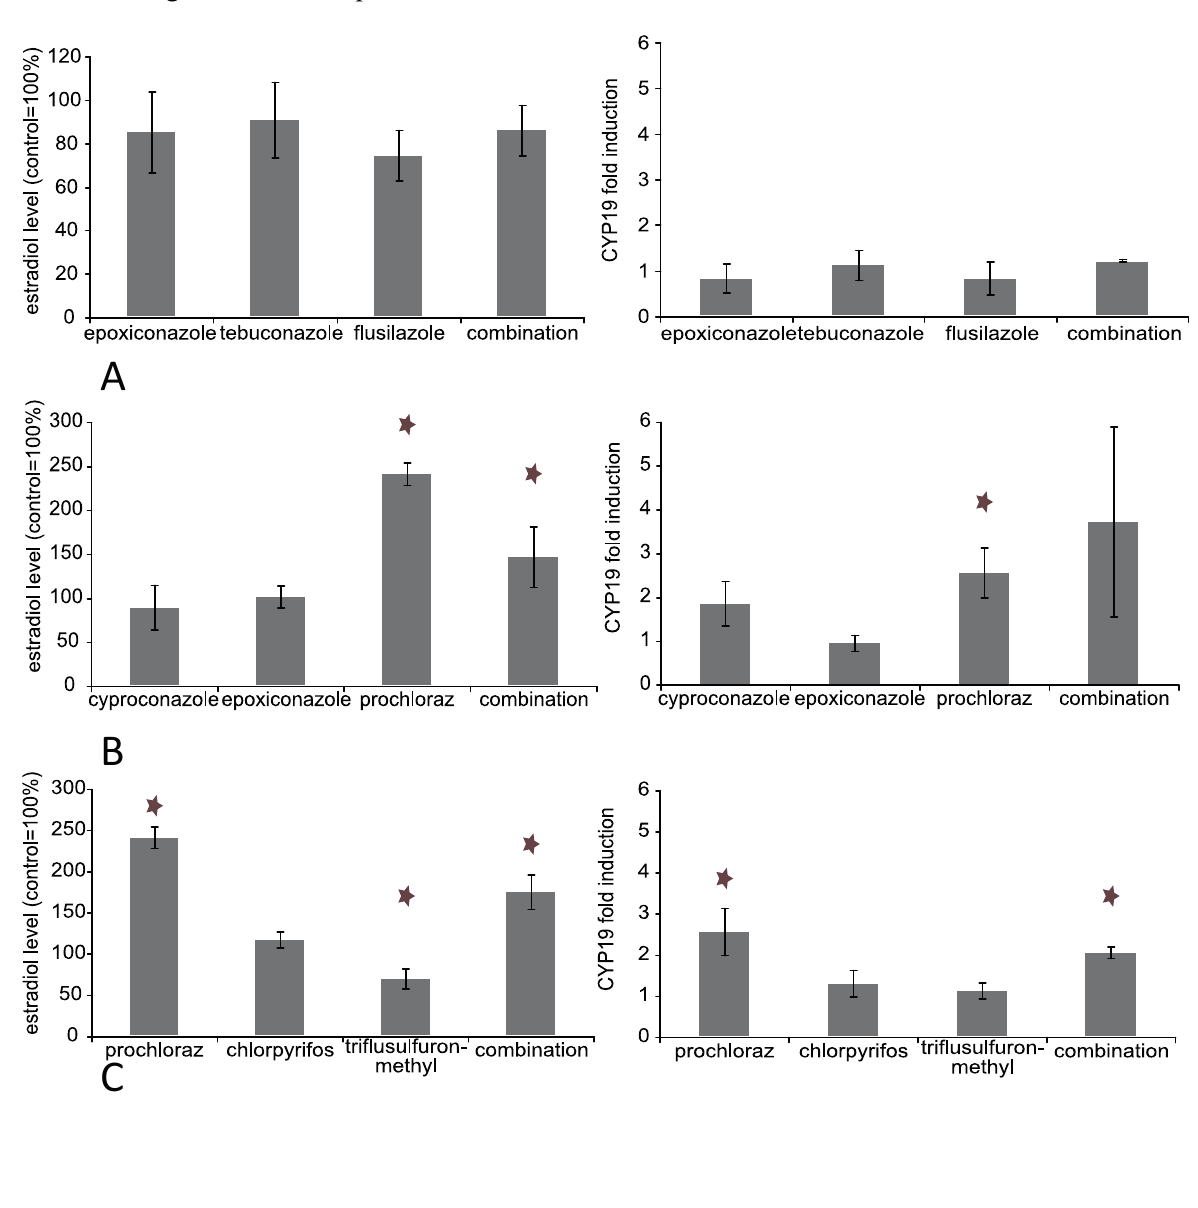
Figure 2. Influence of active substances alone or in combination on estradiol production and CYP19 mRNA expression in Jeg-3 cells. Jeg-3 cells were grown in 6-well cell culture plates for 24 h. Thereafter, the cells were incubated with the substances in total concentrations of 30 and 40 µM as indicated for 48 h individually and in combination: ( A ) 30 µM for epoxiconazole, tebuconazole and flusilazole, ( B ) 40 µM for epoxiconazole, cyproconazole and prochloraz, ( C ) 40 µM for prochloraz, chlorpyrifos and triflusulfuron-methyl. The supernatant was collected and estradiol concentration measured by ELISA as indicated by the manufacturer’s protocol. The RNA of the cells was isolated and reverse transcription performed as described. The data represent the mean for three independent experiments. * Indicates significance with p ≤